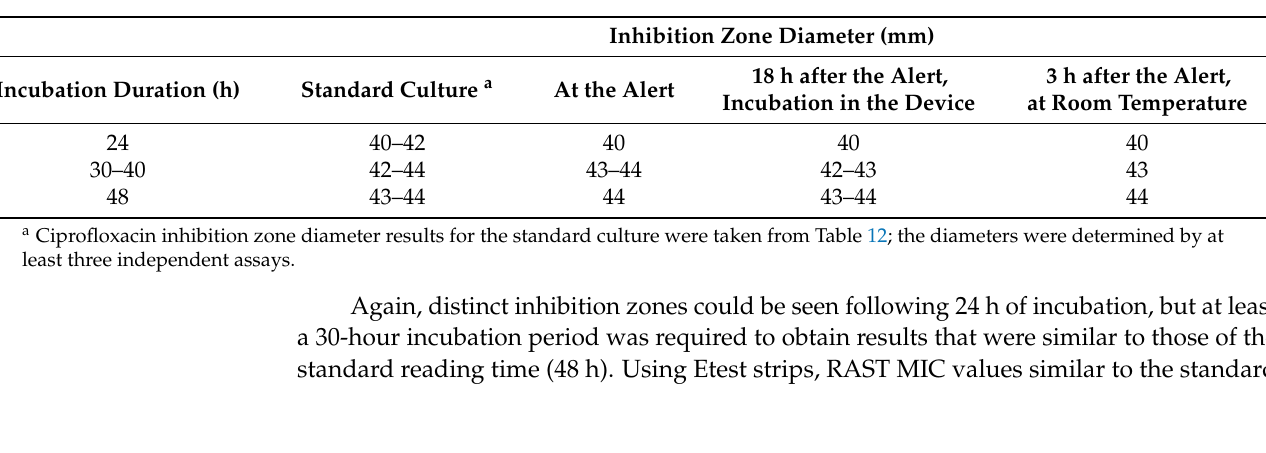
Table 15. Ciprofloxacin inhibition zone diameters of F. tularensis -positive blood